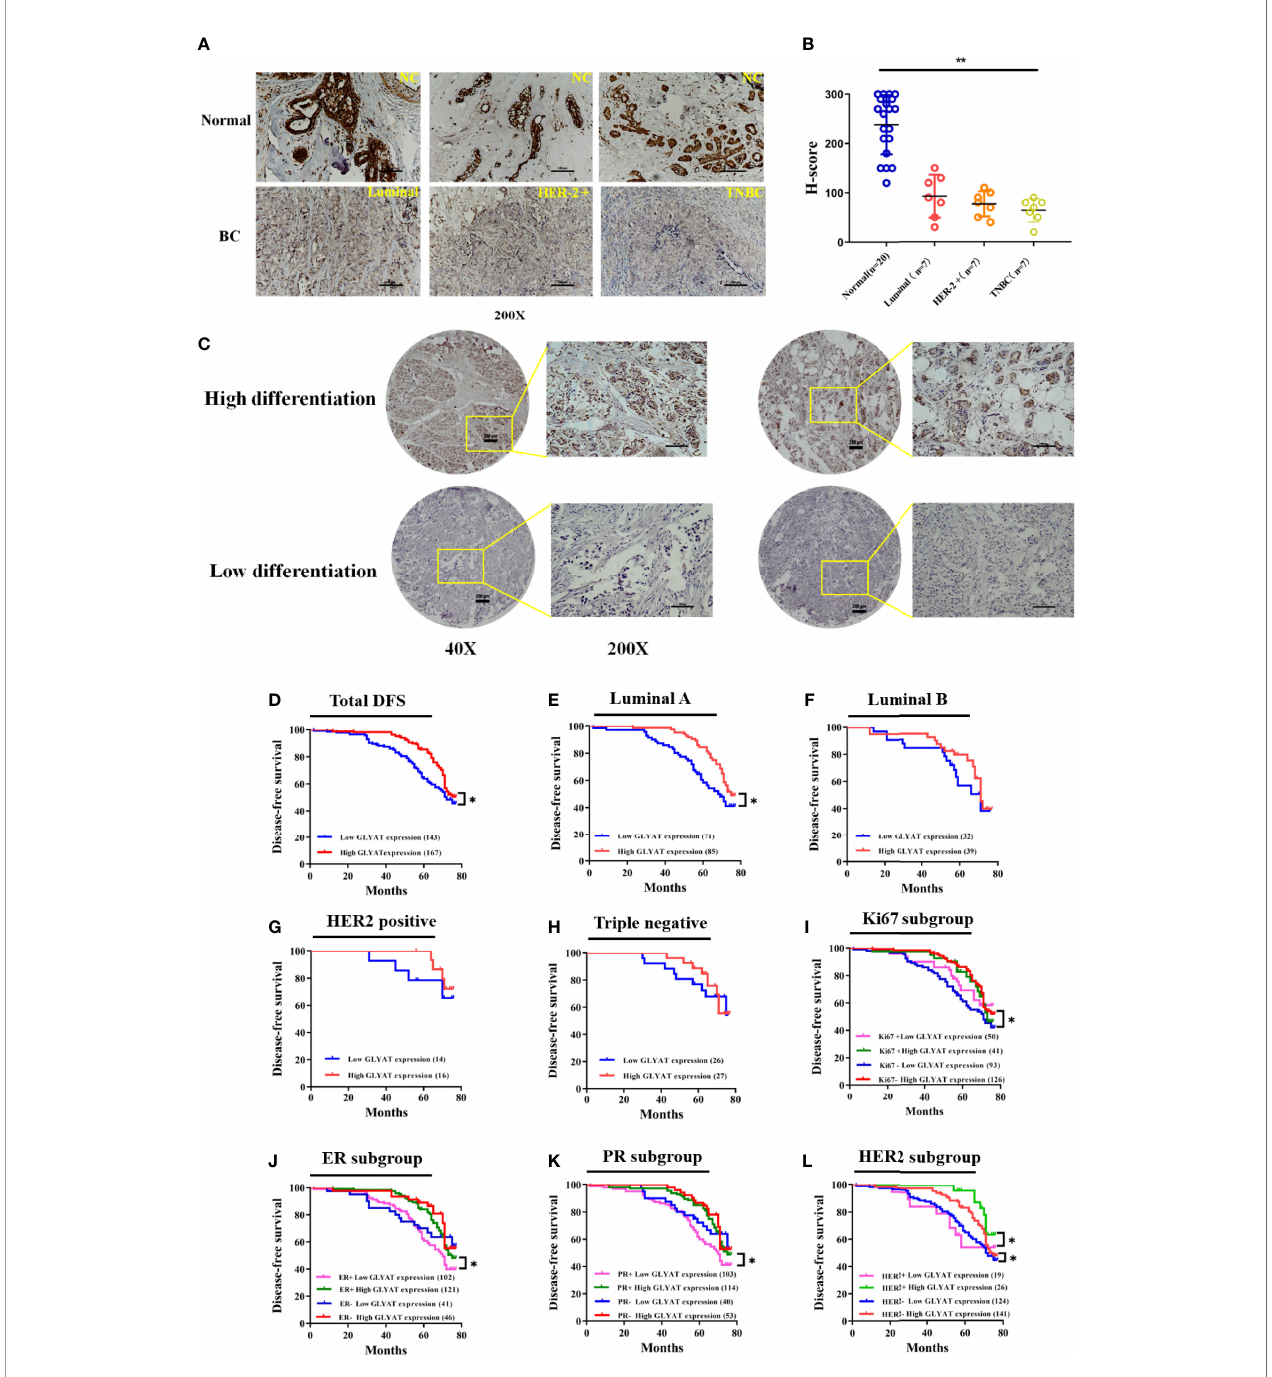
FIGURE 6 | GLYAT is less expressed in BC tissues and correlated with worse survival. (A, B) Immunohistochemical staining showed that GLYAT was downregulated in BC tissues compared with NC. (C) Immunohistochemical staining showed that the lower differentiation of the breast cancer, the less expressed of GLYAT in breast cancer tissues. (D) Kaplan-Meier analysis of DFS in BC patients with different levels of GLYAT. (E – H) Kaplan-Meier analysis of DFS in luminal A, luminal B, HER2 positive and triple negative BC patients with different levels of GLYAT. (I – L) Kaplan-Meier analysis for DFS by Ki67, ER, PR, HER2 status in BC patients with different levels of GLYAT. * p < 0.05, ** p < 0.01. Scale bars for (A) are 200 m m, and for (B) are 50 m m and 200 m